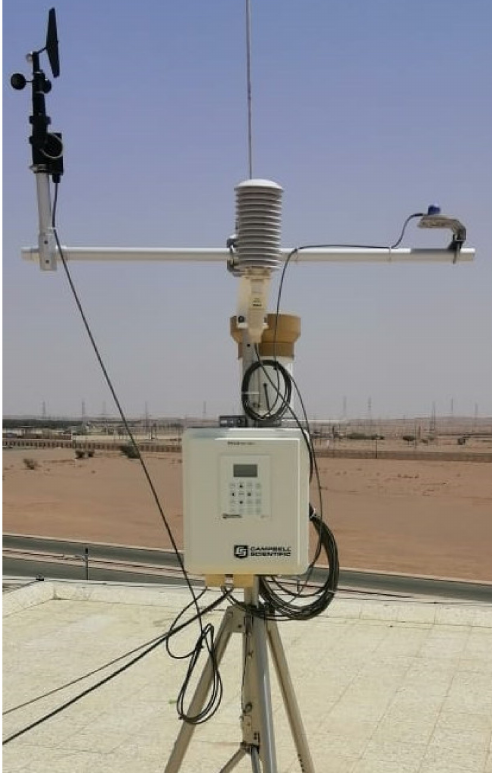
Figure 6. Weather station at Hail University (KSA).